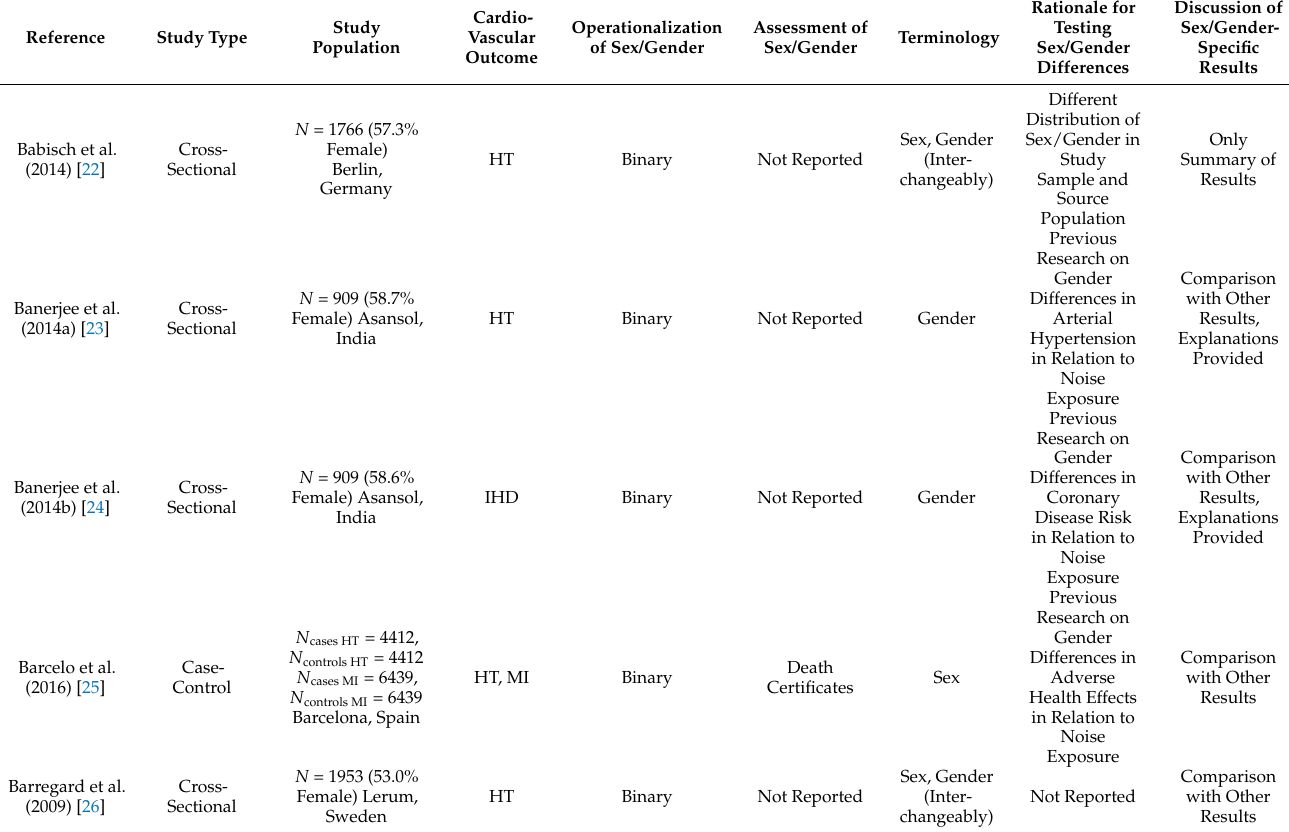
Table 1. Characteristics of the included